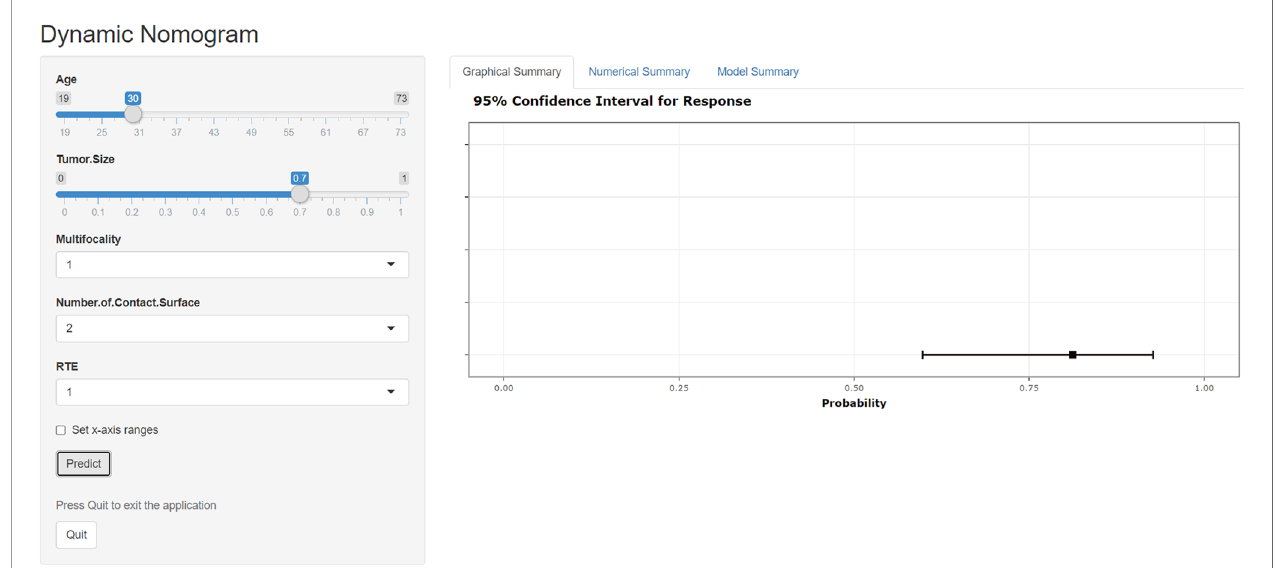
FIGURE 8 | Screen shot of the dynamic web-based nomogram used to predict central lymph node metastasis in cN0 papillary thyroid microcarcinoma (https://